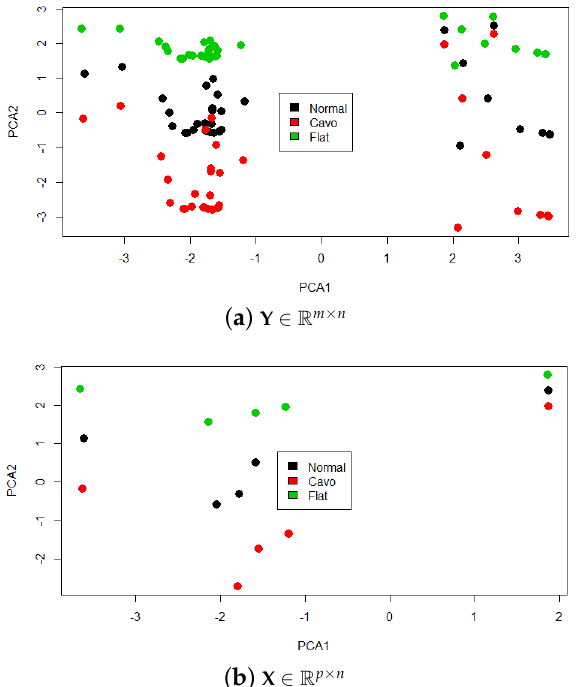
Figure 5. Prototype selection criterion (training set